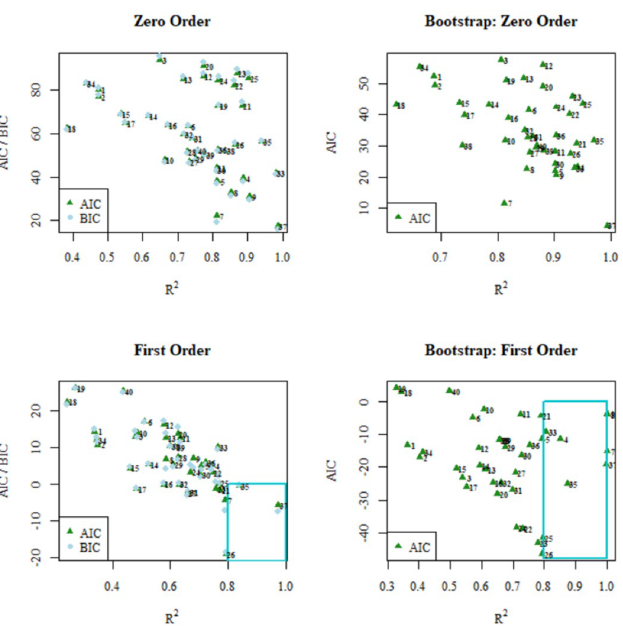
Fig 5. AIC / BIC vs. R 2 plots obtained from linear regression fitting (left) and AIC versus R2 obtained from Bootstrap fitting (right) for the zero-order (top) and first-order (bottom) mathematical models.